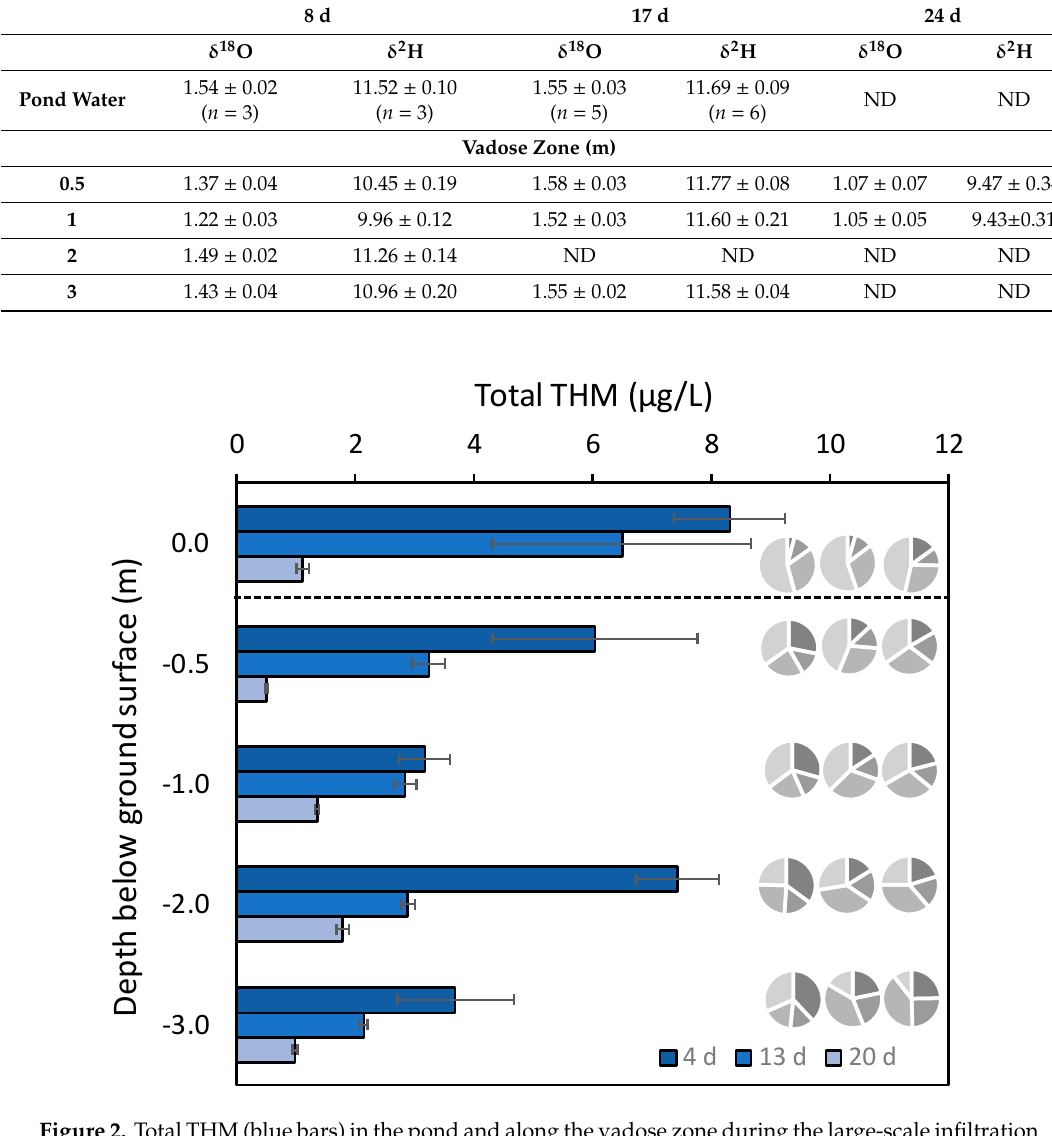
Figure 2. Total THM (blue bars) in the pond and along the vadose zone during the large-scale infiltration event. The error bars represent the standard deviation of three sequentially collected samples at each port. The dashed line illustrates the interface between the surface water and the vadose zone. The distribution of the THM species in each depth at each sampling date (averages for three subsequent samples) is presented in pie plots, with chloroform presented as dark gray, and colors gradually become lighter with the replacement of chlorine substituents with bromine (concentrations are provided on SI).